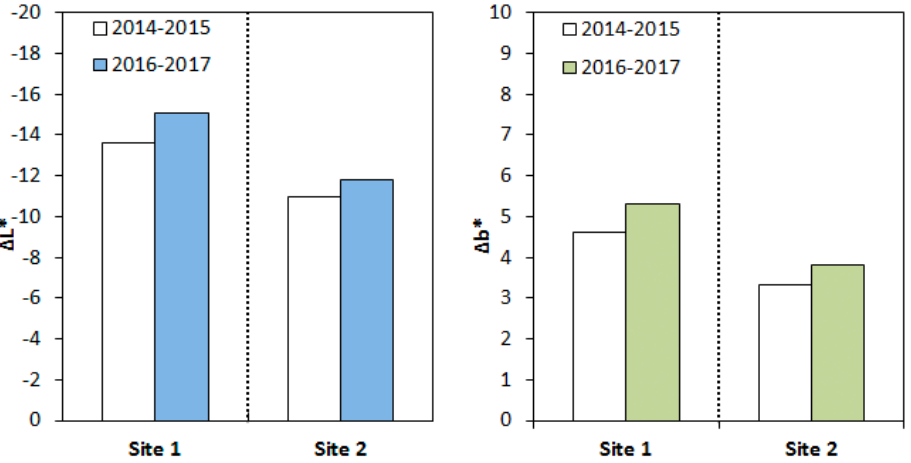
Figure 11. Colorimetric variation of exposed filters: variation of the lightness ( Δ L*, left ) and of the saturation of the yellow coordinate ( Δ b*, right ) during the two exposure periods.